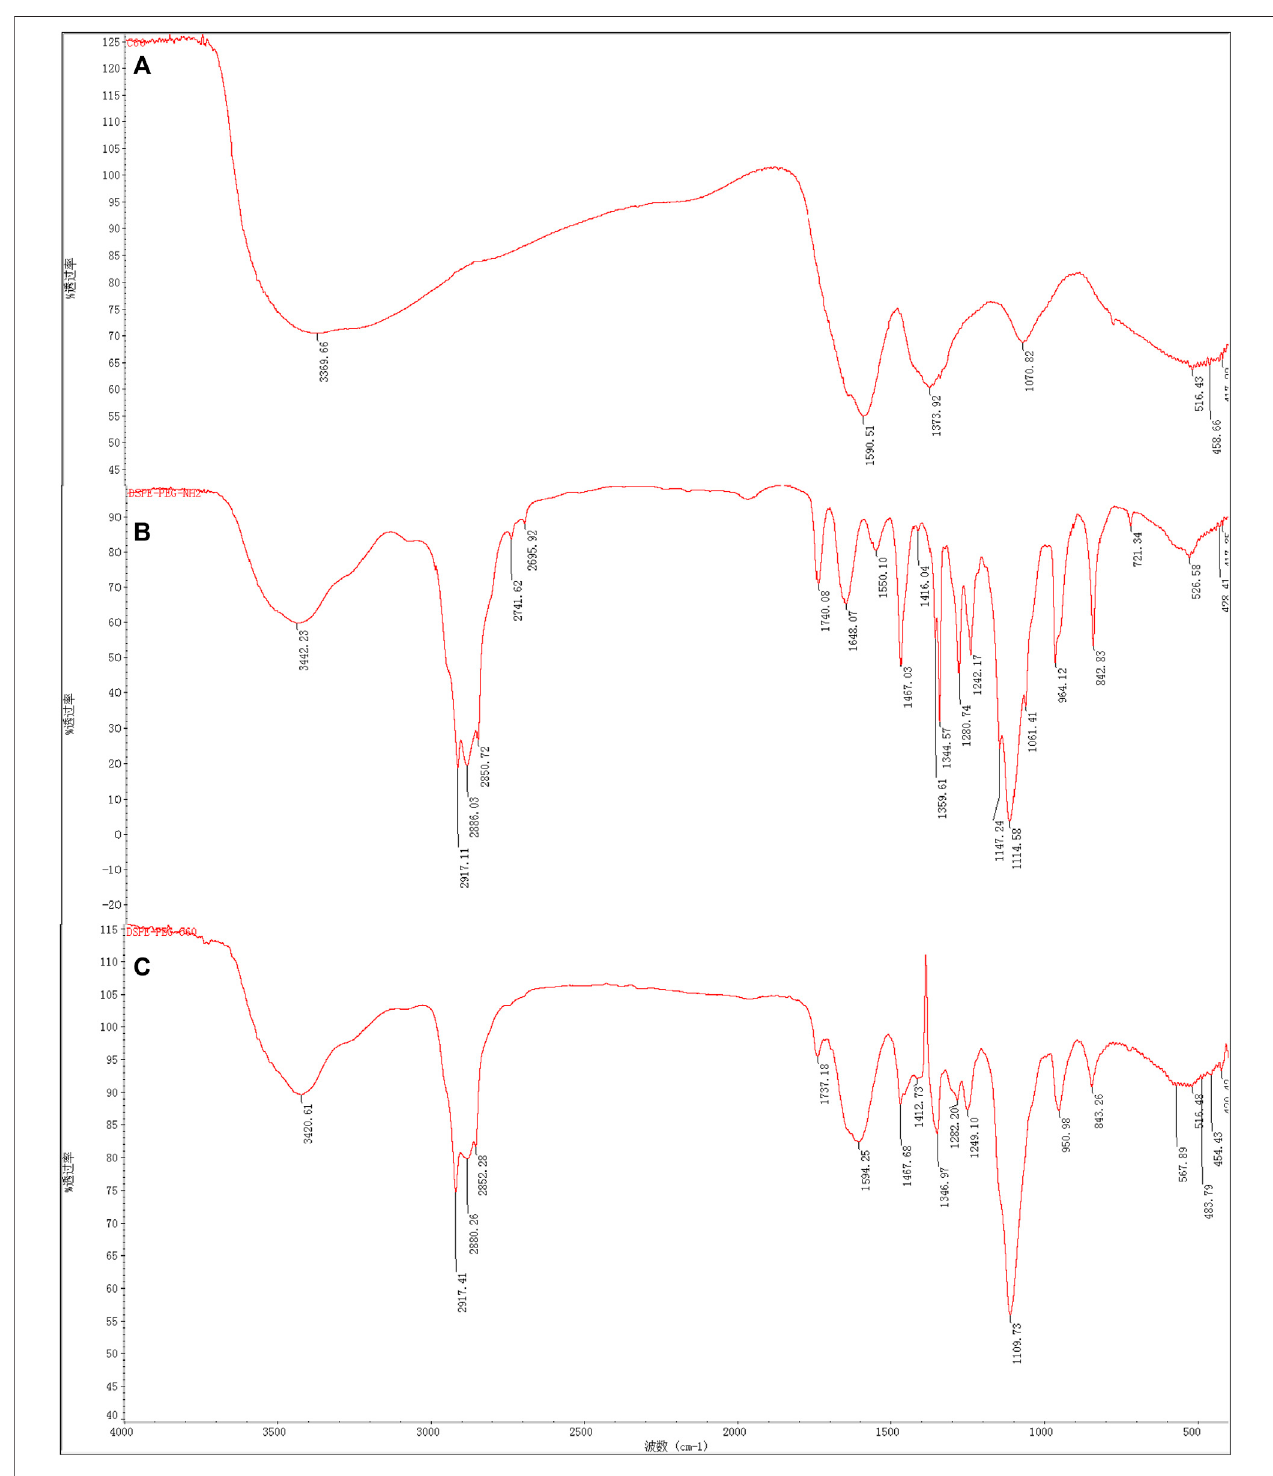
FIGURE 3 | The FT-IR spectra of C60(OH) 22 (A) , DSPE-PEG-NH 2 (B) , and DSPE-PEG-C60 (C) .